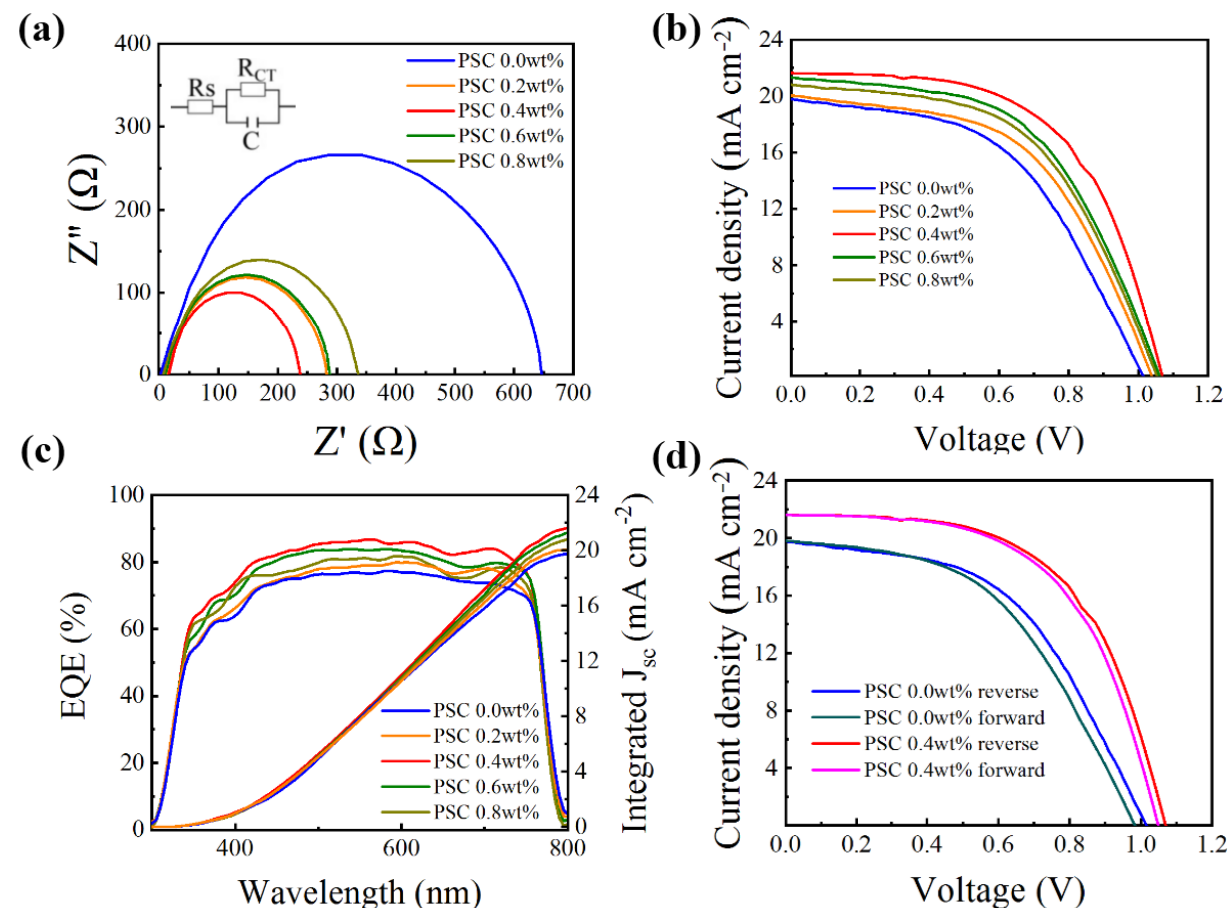
Figure 9. ( a ) Nyquist plots of the PSCs based on different Spiro-OMeTADs. ( b ) J-V characteristics of devices with HTLs doping with different concentrations of CsI measured under AM 1.5 G solar irradiance (100 mW cm −2 ). ( c ) The EQE curve of the PSCs is based on Spiro-OMeTAD with different CsI doping concentrations. ( d ) J-V characteristics of PSC 0.0 wt% and PSC 0.4 wt%, measured at both forward and reverse scanning directions.